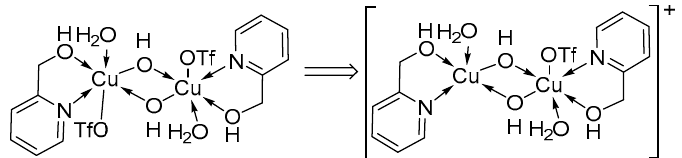
Scheme 11. The Cu 2 -hydroxo dimer that is responsible for the inhibitory e ff ect observed during the Copyright Royal Society of Chemistry,